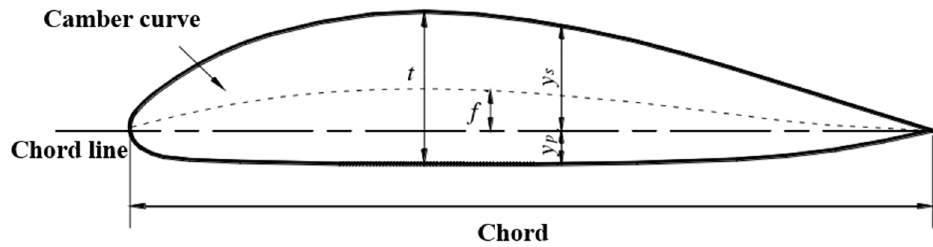
Figure 2. Diagram of the airfoil section.